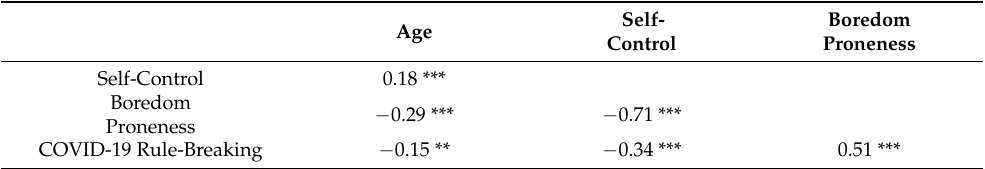
Table 3. Bivariate correlations involving age, self-control, boredom proneness and COVID-19